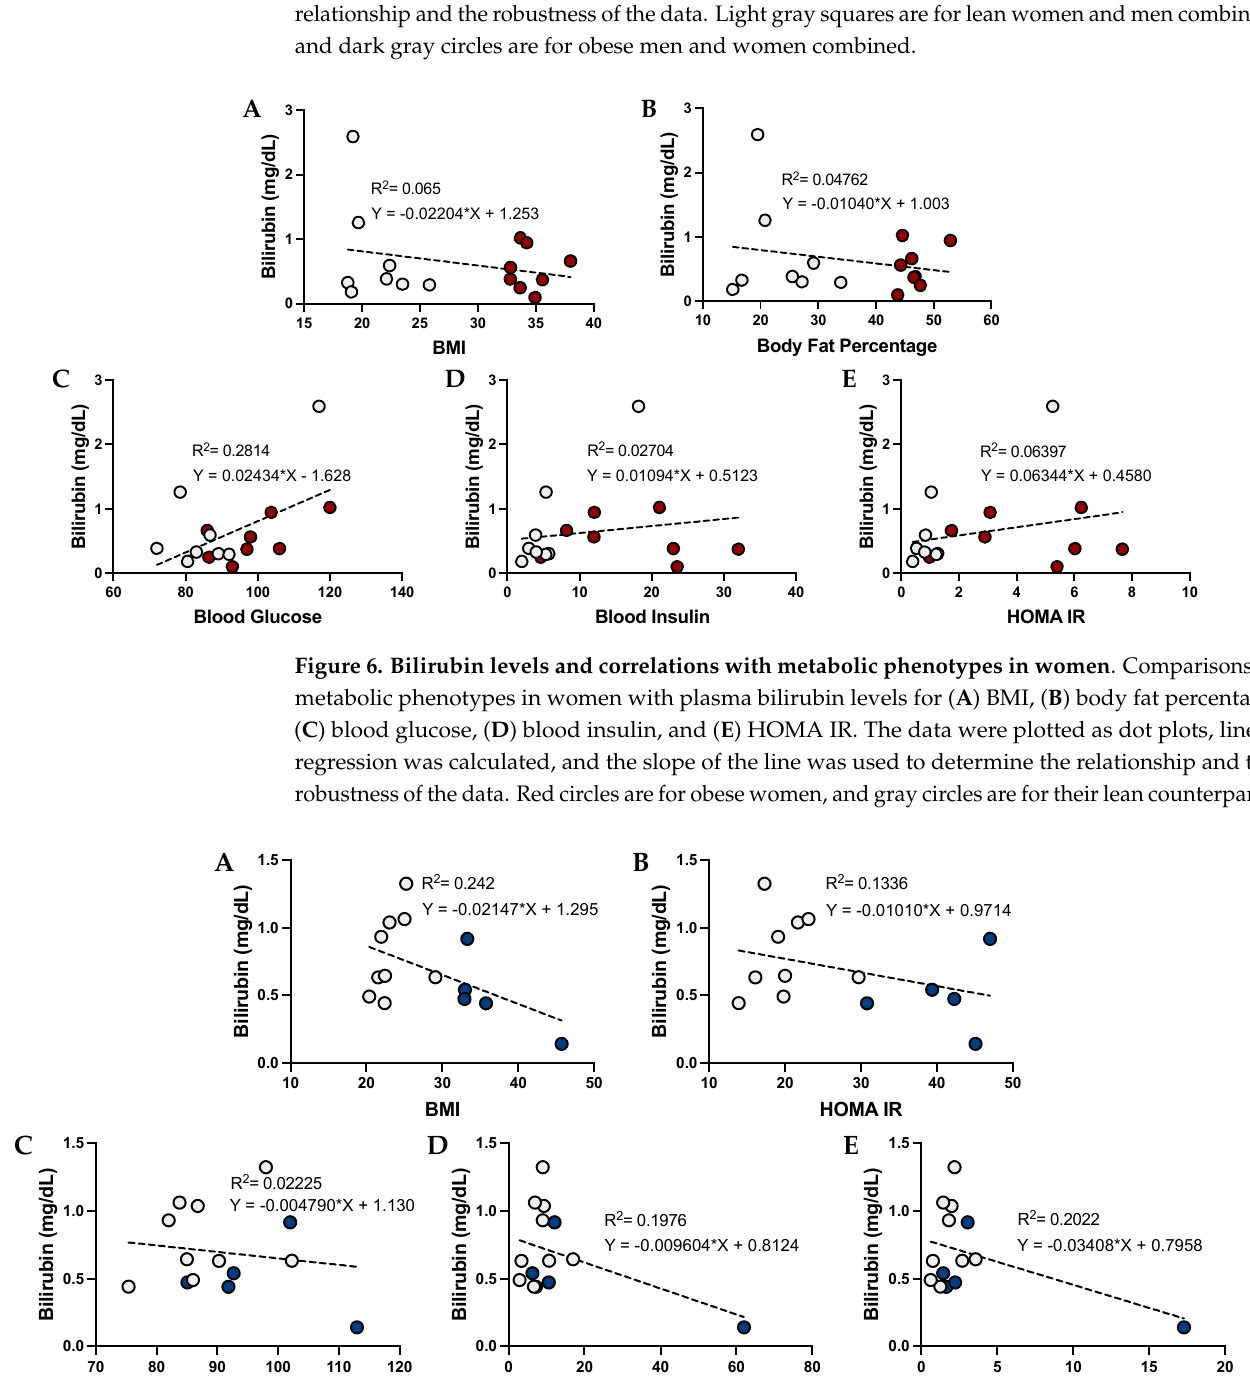
Figure 5. Bilirubin levels and correlations with metabolic phenotypes in women and men . Com- parisons of metabolic phenotypes in women and men with plasma bilirubin levels for ( A ) BMI, ( B ) body fat percentage, ( C ) blood glucose, ( D ) blood insulin, and ( E ) HOMA IR. The data were plotted as dot plots, linear regression was calculated, and the slope of the line was used to determine the relationship and the robustness of the data. Light gray squares are for lean women and men combined, and dark gray circles are for obese men and women combined.